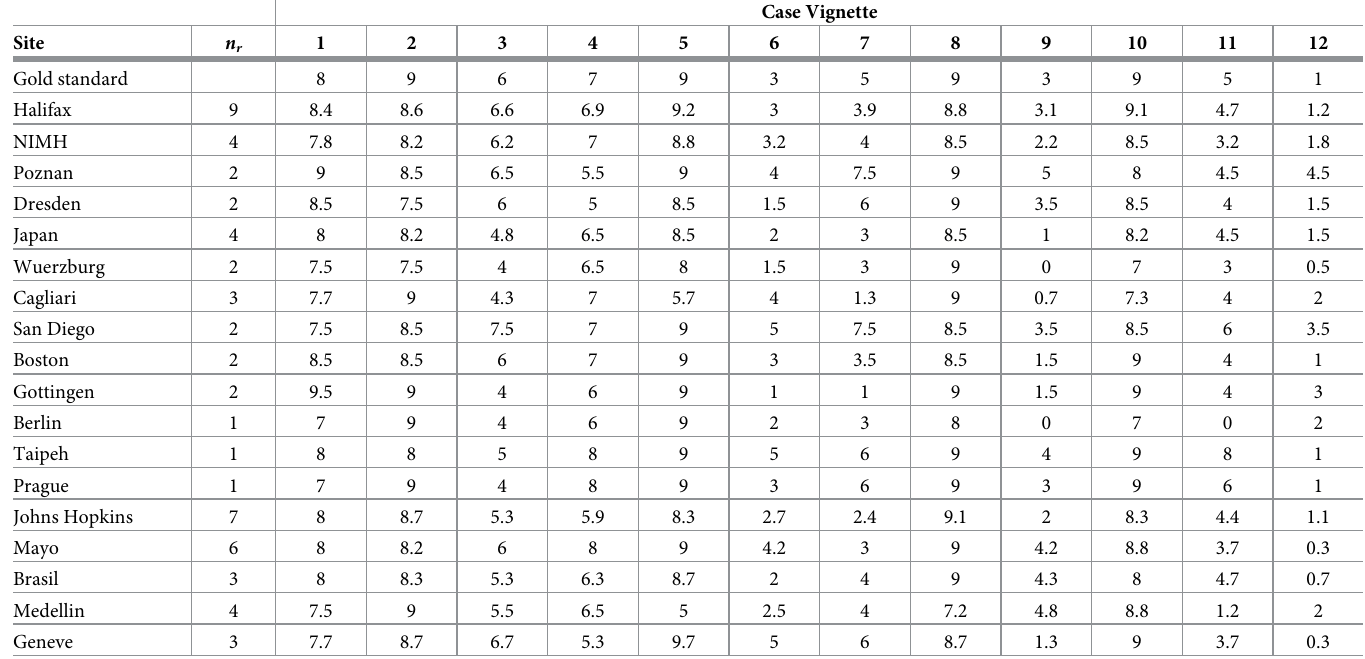
Table 1. Number of raters and mean scores across sites. The total number of raters ( n r ) was